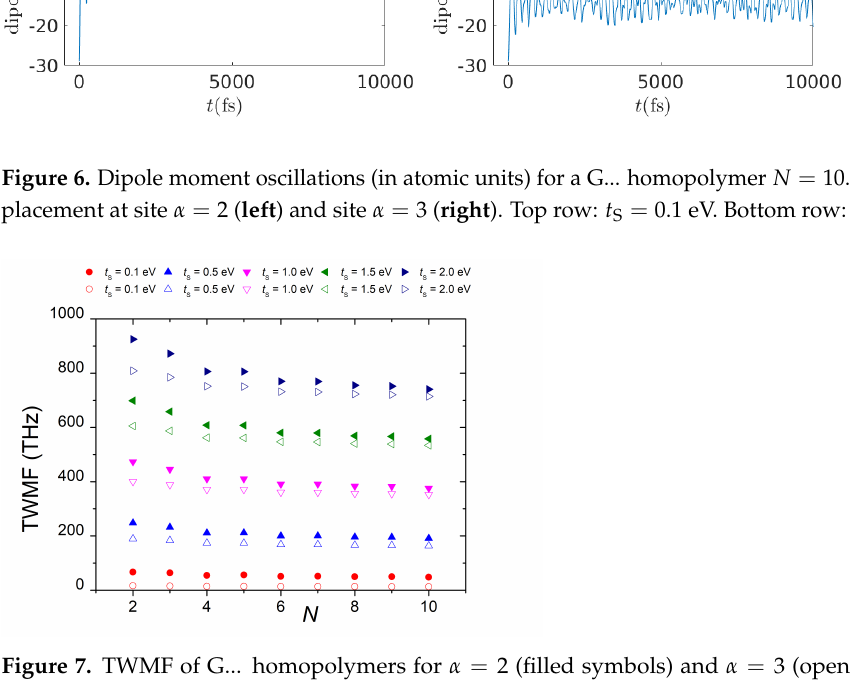
Figure 7. TWMF of G... homopolymers for α = 2 (filled symbols) and α = 3 (open symbols) for various t S